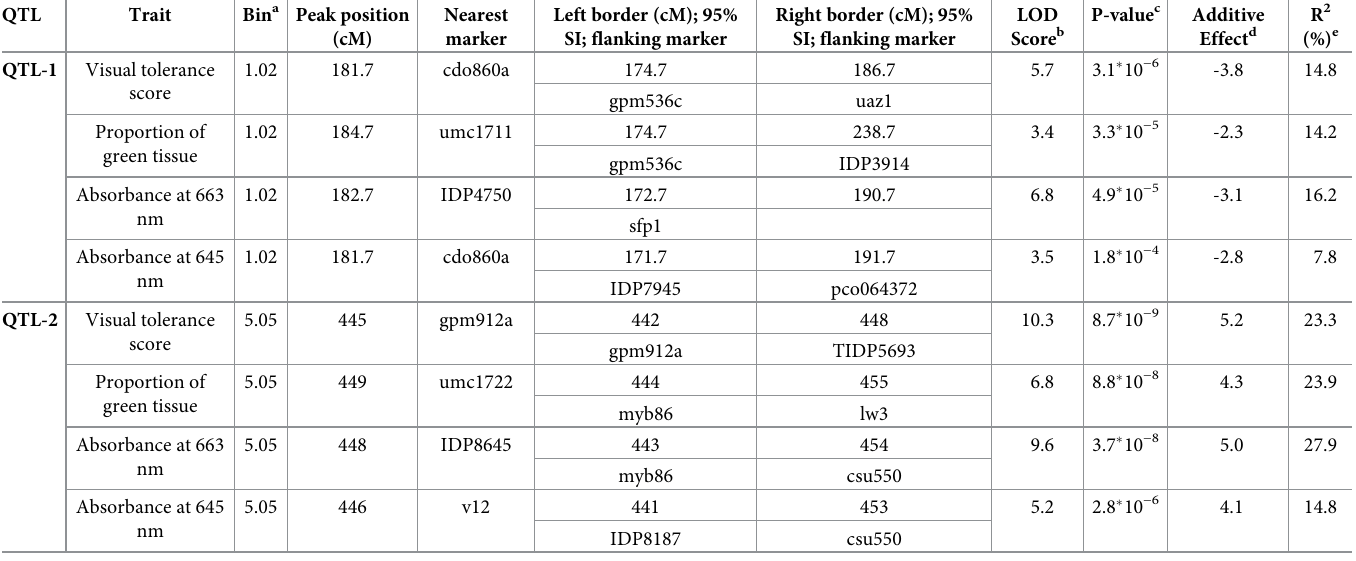
Table 3. QTLs detected for controlling leaf phenotype following low temperature exposure in the IBM Syn4